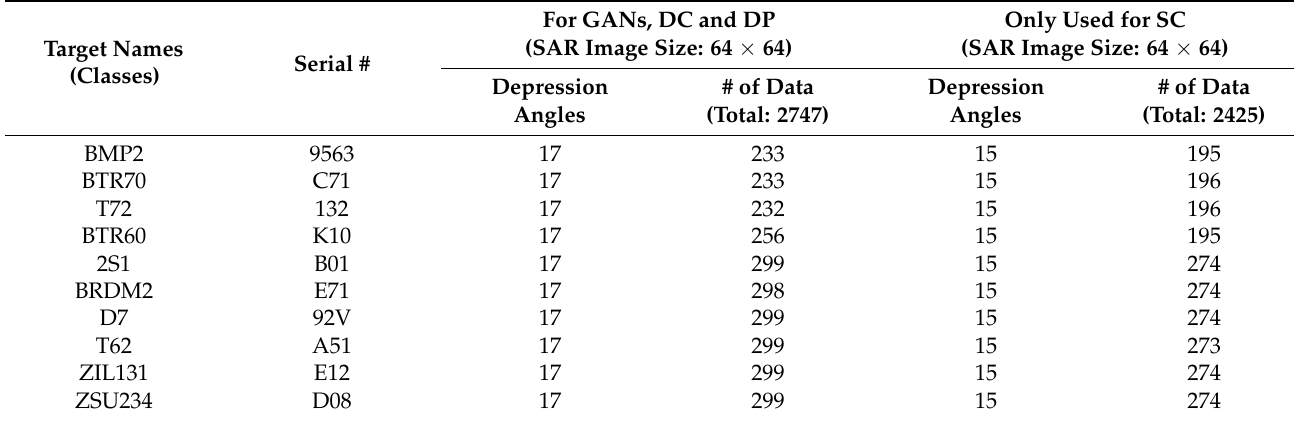
Table 1. The information of MSTAR data for